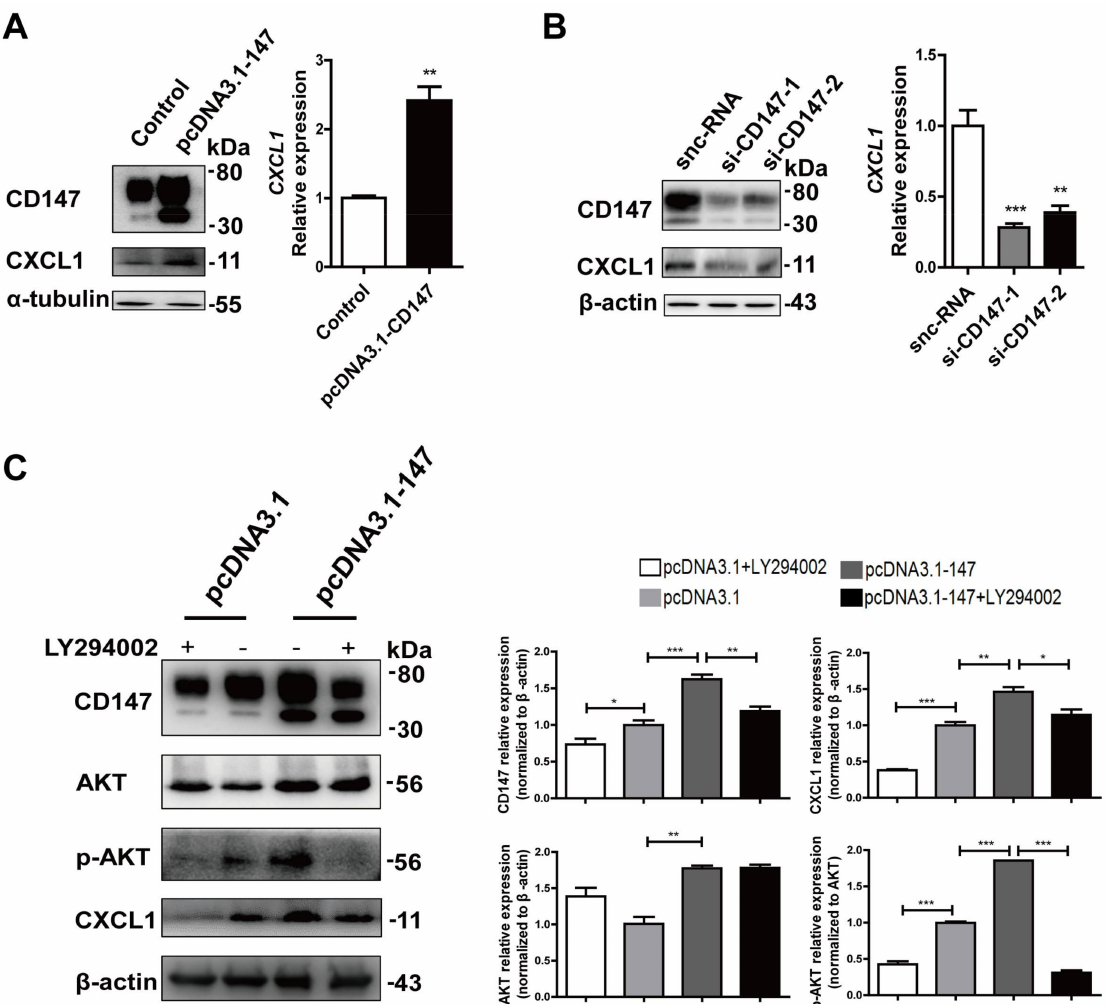
Figure 6. CD147 regulated CXCL1 expression in HSCs via PI3K/AKT pathway. ( A ) Western blot and real-time RT-PCR analysis of CD147 and CXCL1 in LX-2 cells that transfected with pcDNA3.1-CD147; ( B ) Western blot and real-time RT-PCR analysis of CD147 in LX-2 cells transfected with CD147 siRNA. LX-2 cells were transfected with sncRNA as the control; ( C ) Western blot analysis of CD147, AKT, p-AKT, and CXCL1 in pcDNA3.1-CD147-transfected LX-2 cells that were pre-incubated with 10 µ mol/L LY294002. Western densitometry was performed for three independent experiments. Cells were transfected with pcDNA3.1(+) as the control. GAPDH was used as the normalization control. The results were shown as the mean ± SD. * p < 0.05, ** p < 0.01, *** p <